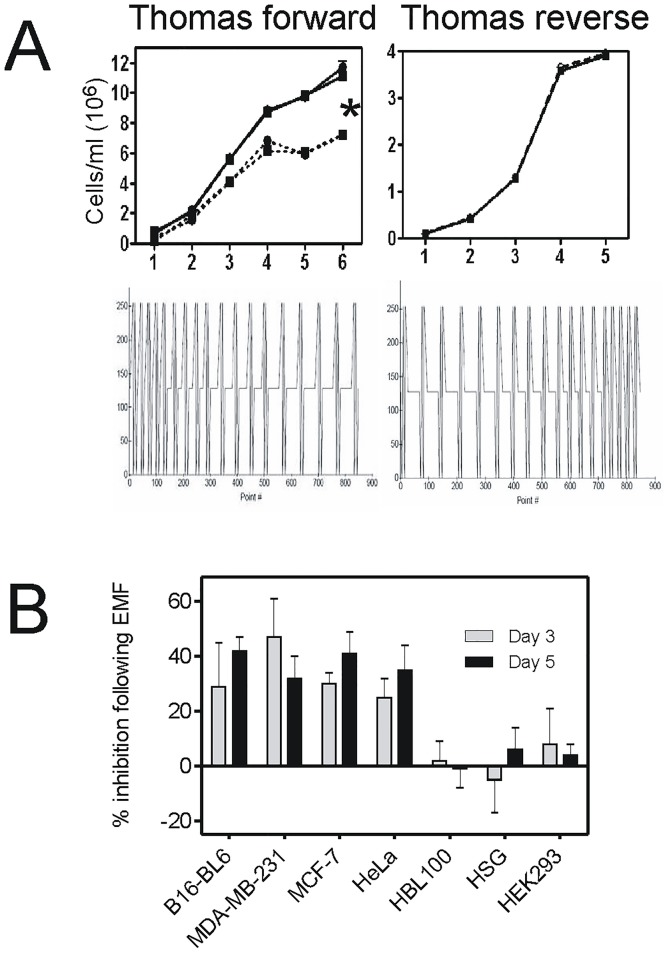
Exposure to Thomas-EMF alters cell proliferation.A. B16-BL6 cells were exposed to the Thomas-EMF pattern (dotted line) for 1 h/day (triangle) or 4 h/day (circle) or the Thomas-reverse-EMF for 1 h/day (dotted line) compared to a sham field (solid lines) and cell number determined on a hemocytometer. The data shows the average ± SD cell number for one of 3 experiments where * indicates p<0.05 between Thomas-EMF and sham groups (ANOVA). B. Malignant (MDA-MB-231, MCF-7, and HeLa) or non-malignant (HBL-100, HEK293T, and HSG) cell cultures were treated with the Thomas-EMF or sham field for 1 h/day and the average number of cells ± SD was determined each day. The percent inhibition in cell number for days 3 and 5 was determined [(sham—Thomas-treated)/sham] for at least 3 separate experiments and the average and standard deviation for each cell line is shown where * indicates p<0.05 between Thomas-EMF and sham groups.